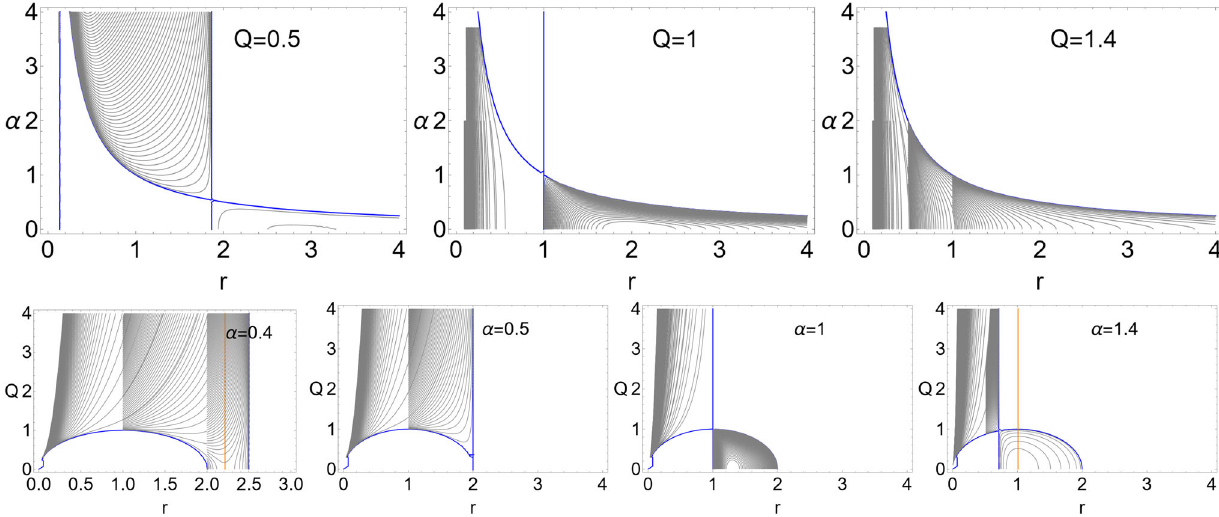
Fig. 7 Metric bundles in the accelerating charged BH spacetimes of Eq. (22) are shown in the plane α − r (upper line) and Q − r (bottom lime), where Q is the charge parameter, α is the acceleration parameter. Here M = 1 and θ = π/ 2. Blue curves represent horizons